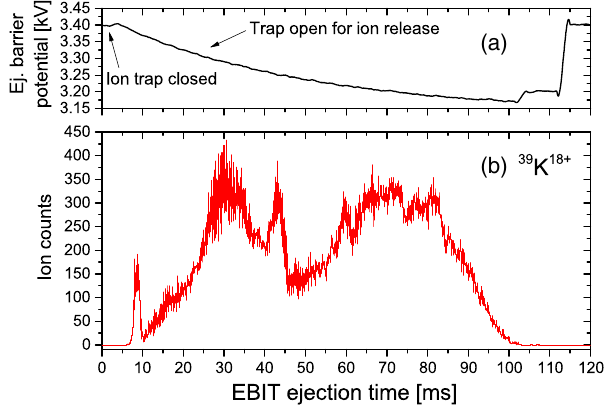
FIG. 11. (a) Exponential voltage ramp function used for stretching 39 K 18 þ ion pulses ejected from the ReA EBIT, (b) stretched ion time distribution measured with an MCP used by an experiment.